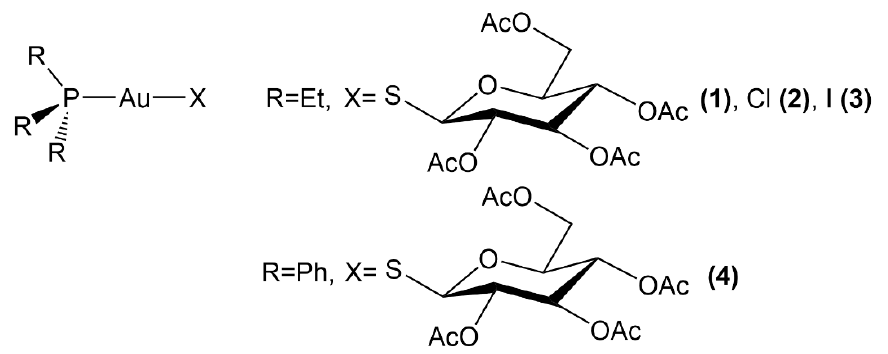
Figure 3 . Au(I)-based structures, ( 1 ) auranofin, ( 2 ) Et 3 PAuCl, ( 3 ) auranofin iodide, and ( 4 ) auranofin with phenyl